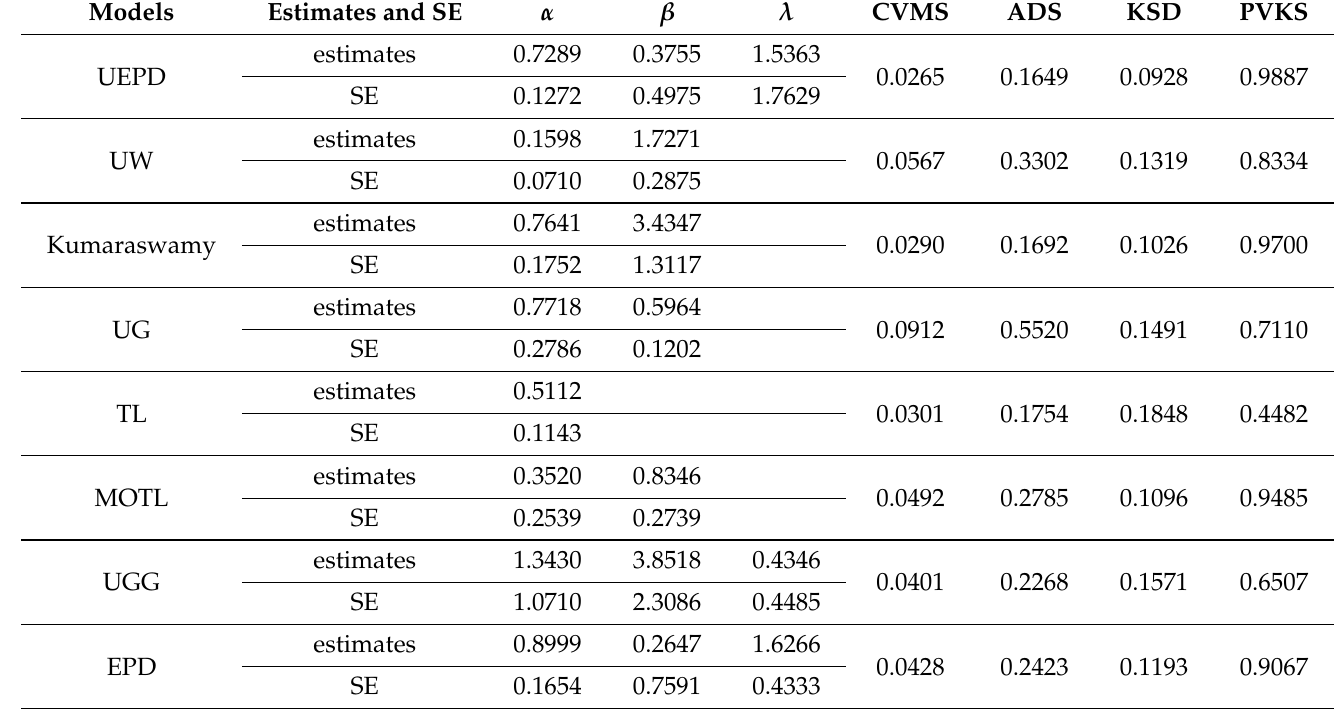
Table 11. M L E and SE with different measures of goodness of fit for the failure of 20 components data.